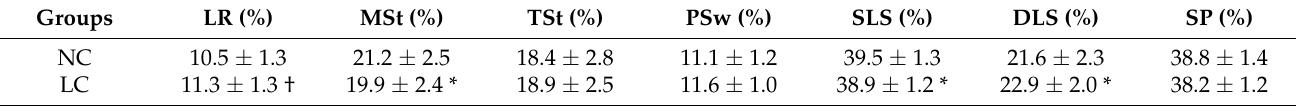
Table 3. Differences of the subdivisions of gait cycles between the normal cognition group and lower cognition group. Groups